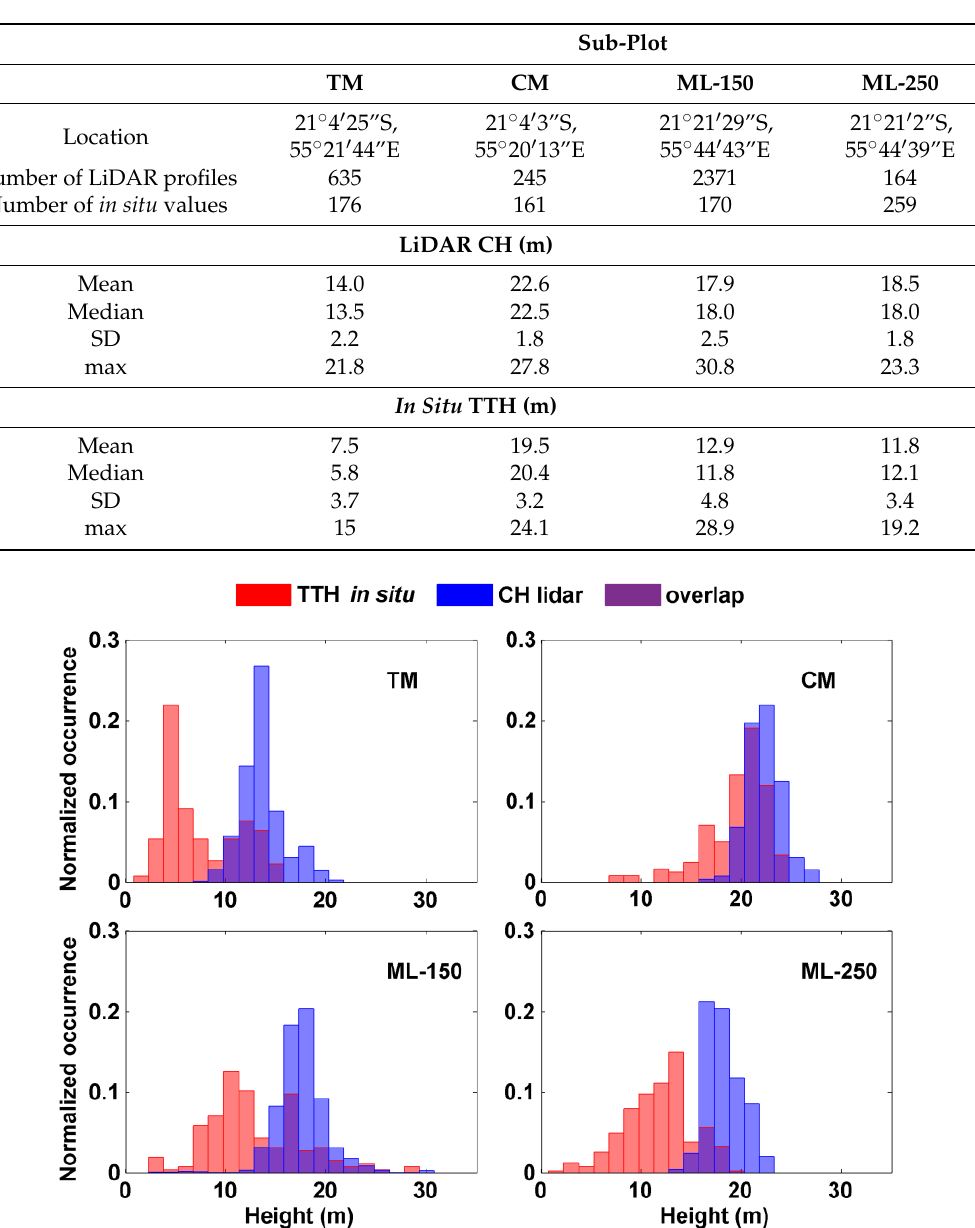
Table 4. Statistics (mean, median, maximal values and standard deviation (SD)) for both the tree top height (TTH) as measured from the in situ census and the canopy height (CH) retrieved by LiDAR measurements in 4 sub-plots of ~0.2 ha: Tamarind (TM), Cryptomeria (CM) and Mare-Longue (ML-150, -250) sites. The values are given for sub-plots well identified in the main sites (Table 1). All trees with diameters at breast height higher than 7 cm are considered in in situ measurements.